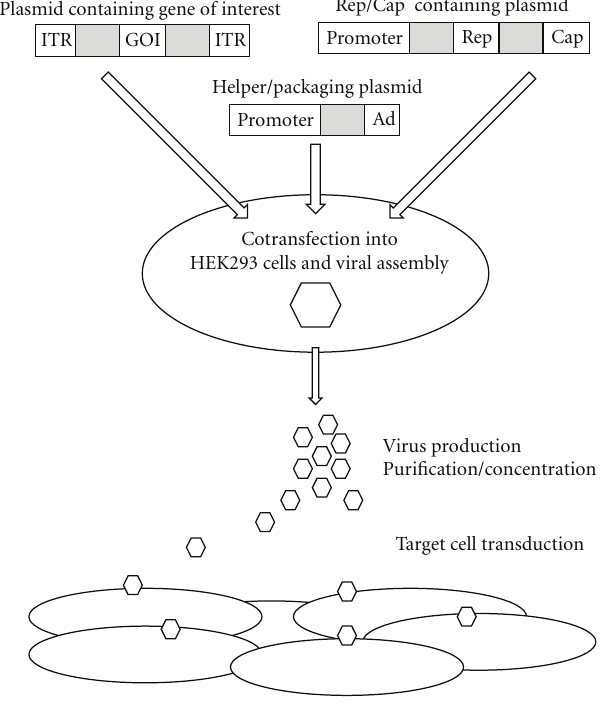
Figure 1: Triple transfection strategy for the in vitro production of recombinant adenoassociated viruses